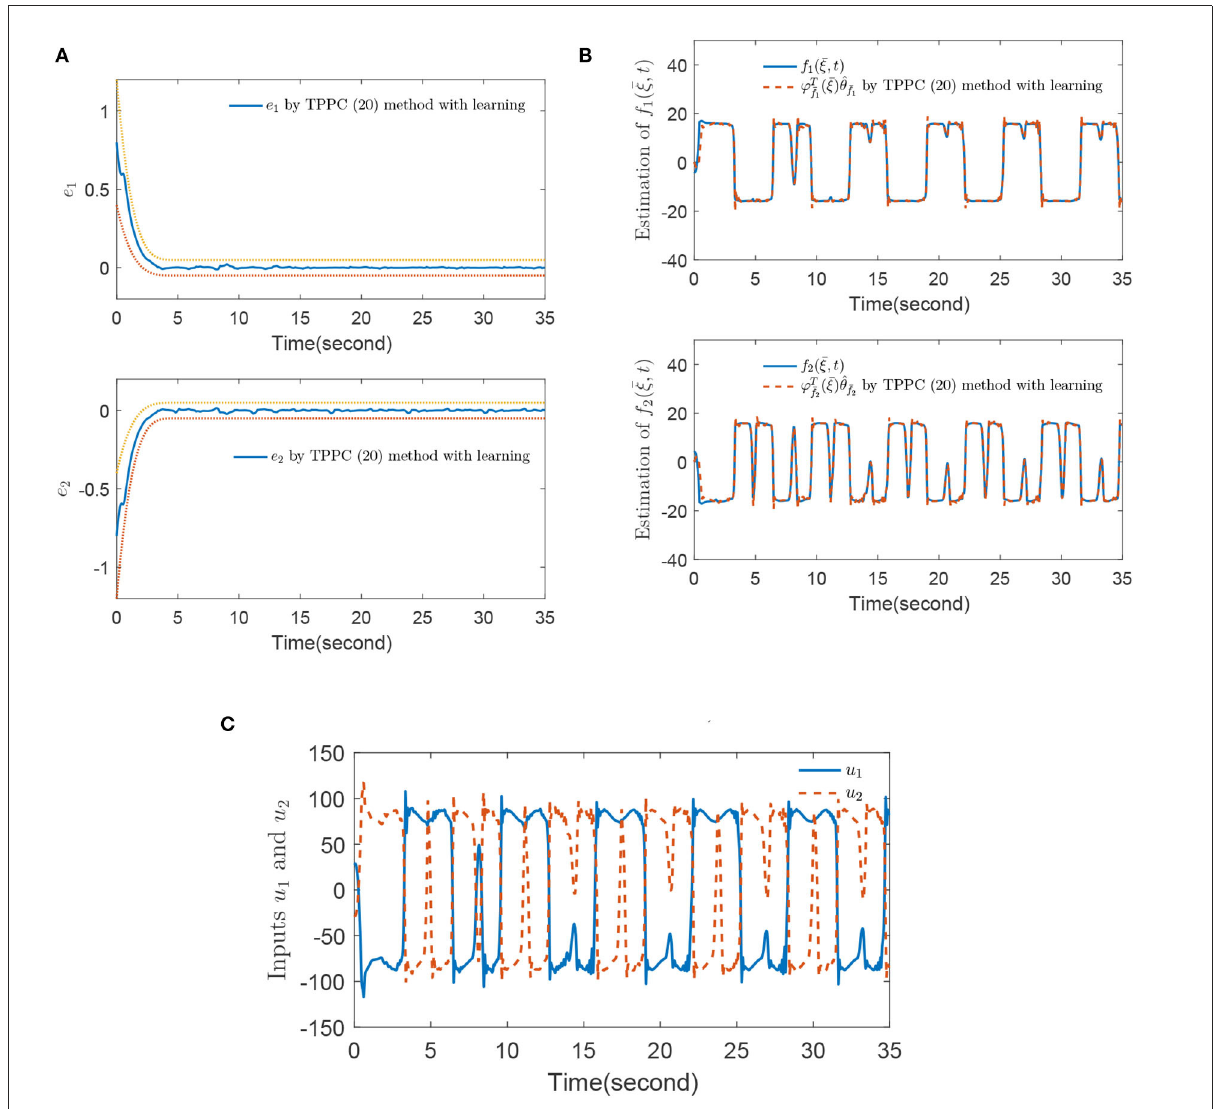
FIGURE4 (A) Tracking errors e 1 and e 2 , (B) estimation of f 1 ( ¯ ξξξ , t ) and f 2 ( ¯ ξξξ , t ), and (C) control inputs u 1 and u 2 by using the TPPC method (Equation 20) with